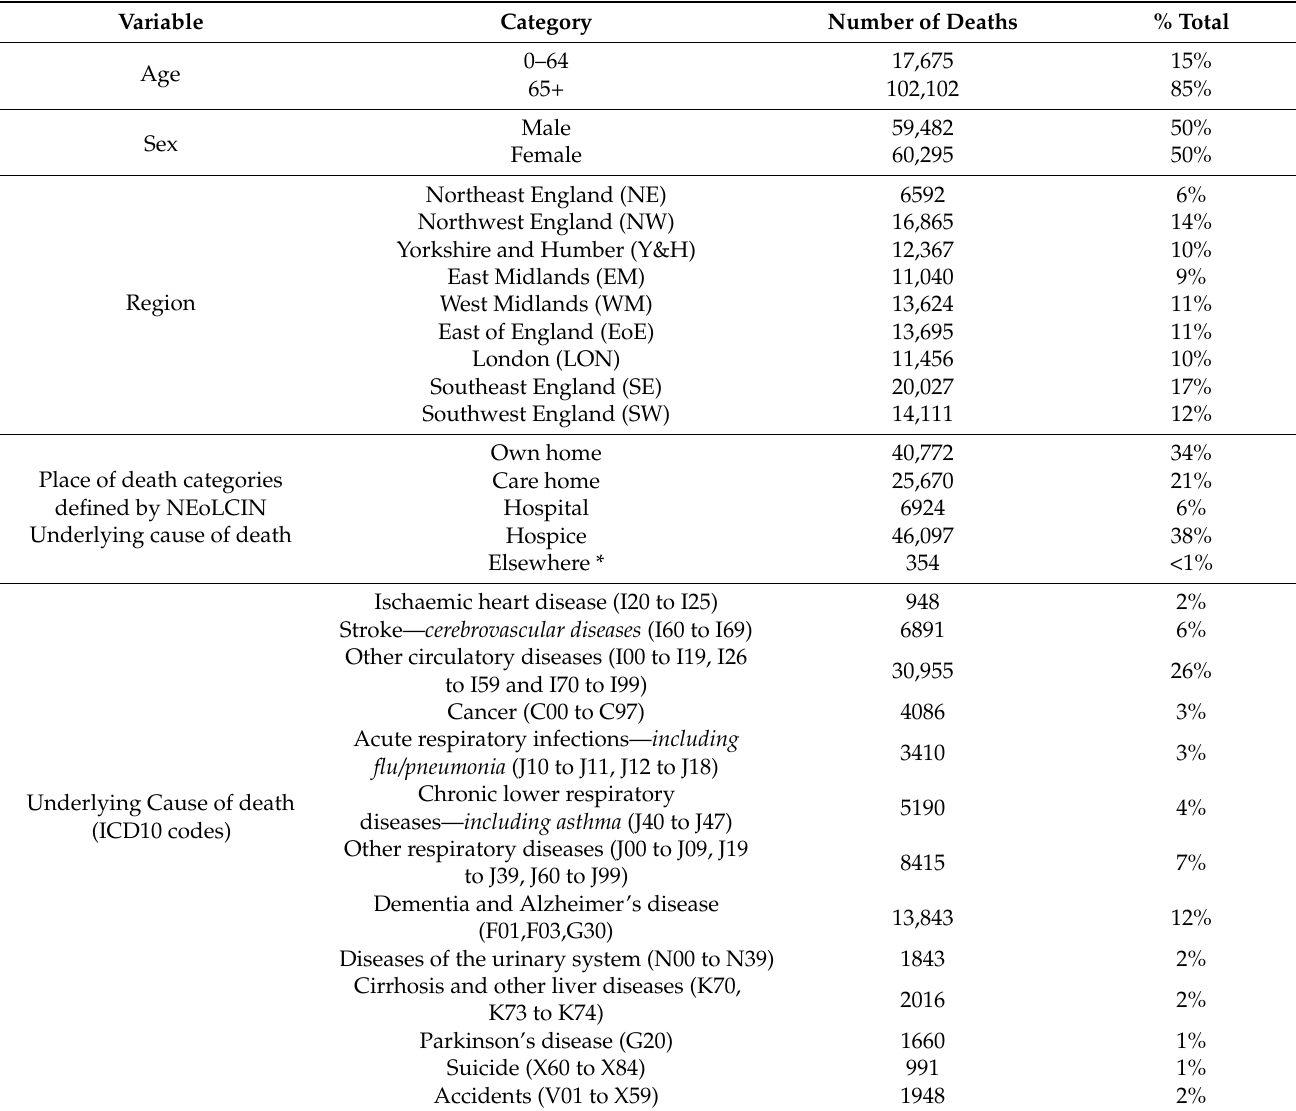
Table 1. Variables used in analysis with the total number of deaths by category and percentage of total number of deaths over the study period, 1 June to 15 September 2020. ICD 10 codes are provided for each cause of death